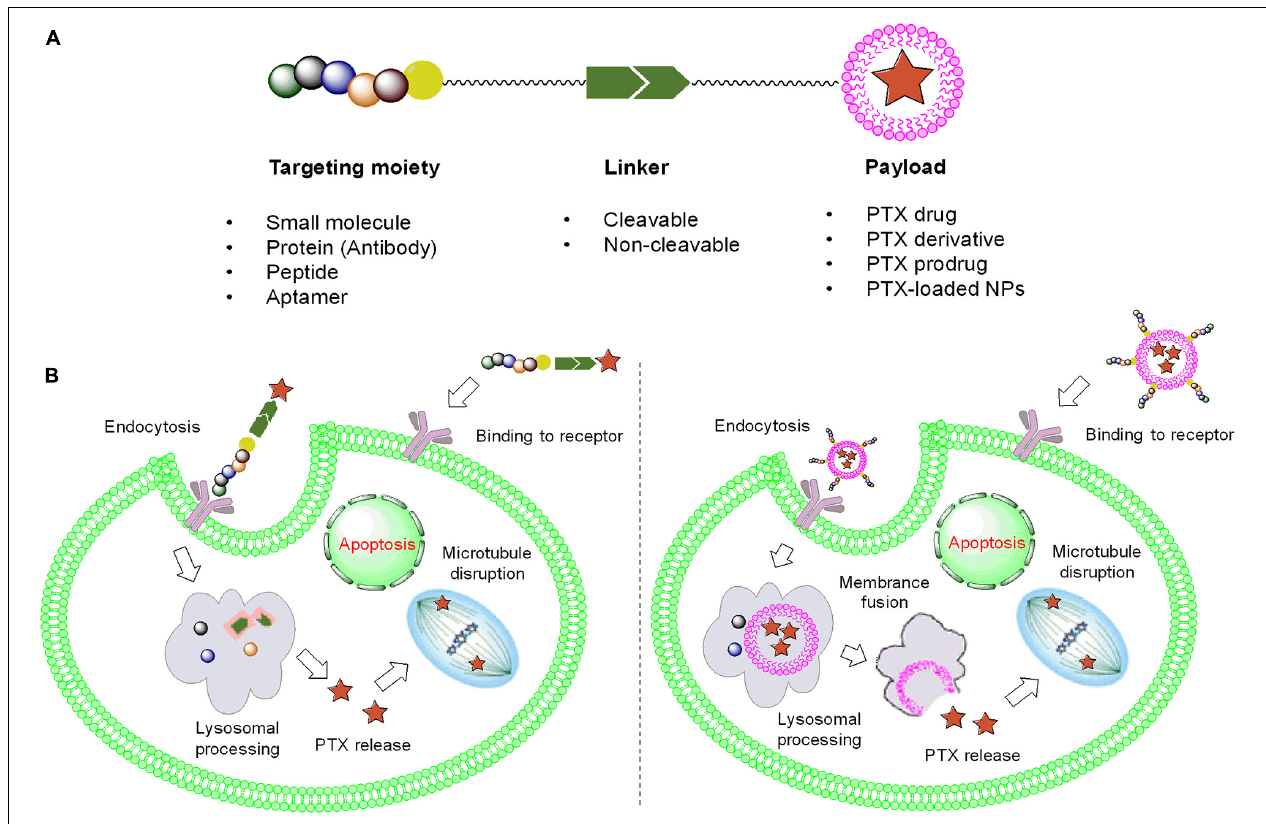
FIGURE 2 | The framework and functional mechanism of ligand-PTX drugs. (A) The composition of ligand-PTX drugs. (B) Endocytosis of ligand–PTX conjugates and ligand-coated NPs with a PTX payload.